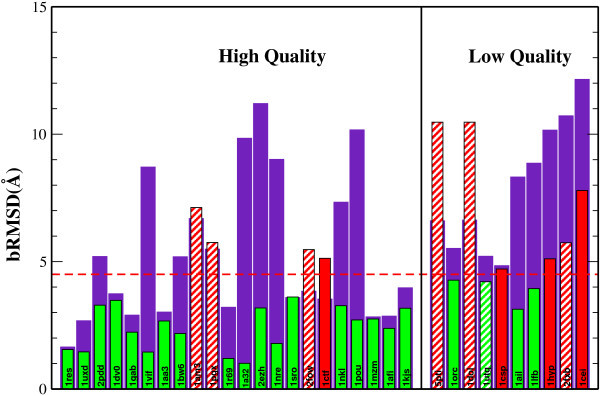
CαRMSD of predicted structures. The Cα RMS deviation between the best cluster and the experimental conformation for the high and low-quality decoy sets (ordered by protein size) shows no decrease of the prediction probability with protein size for the high quality decoy sets. Green bars indicate correct predictions, red bars prediction failures. Shaded bars indicate indecisive simulations (see text), where there was no 'largest cluster' in the top 50 decoys. We note that there is only one genuine prediction failure for the high-quality decoy sets. The horizontal dashed line indicates the acceptance threshold for correct predictions. The purple bars designate the deviations of the best decoys when the same clustering technique is applied with the original ROSETTA scoring function.